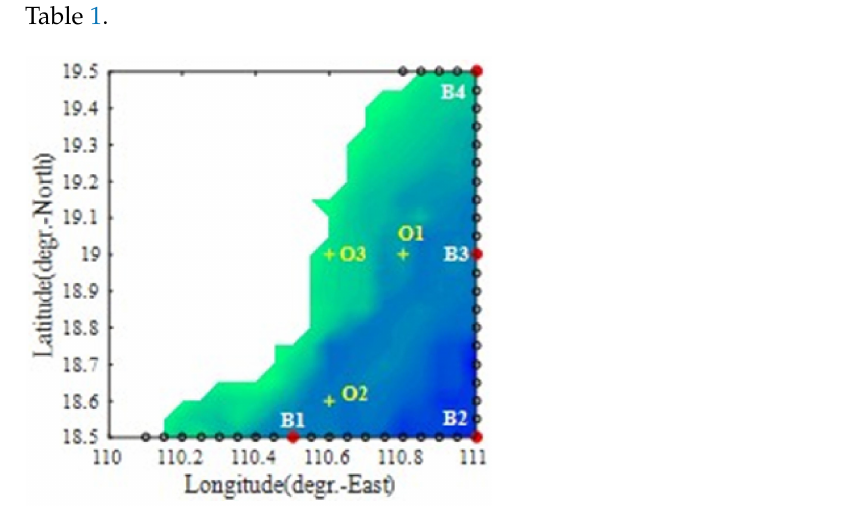
Figure 2. Child computational domain for the Wanning offshore area, and locations of boundary points (black circles), check points B1–B4 (red circles), and check points O1–O3 (yellow “+” symbols). Table 1. Locations of check